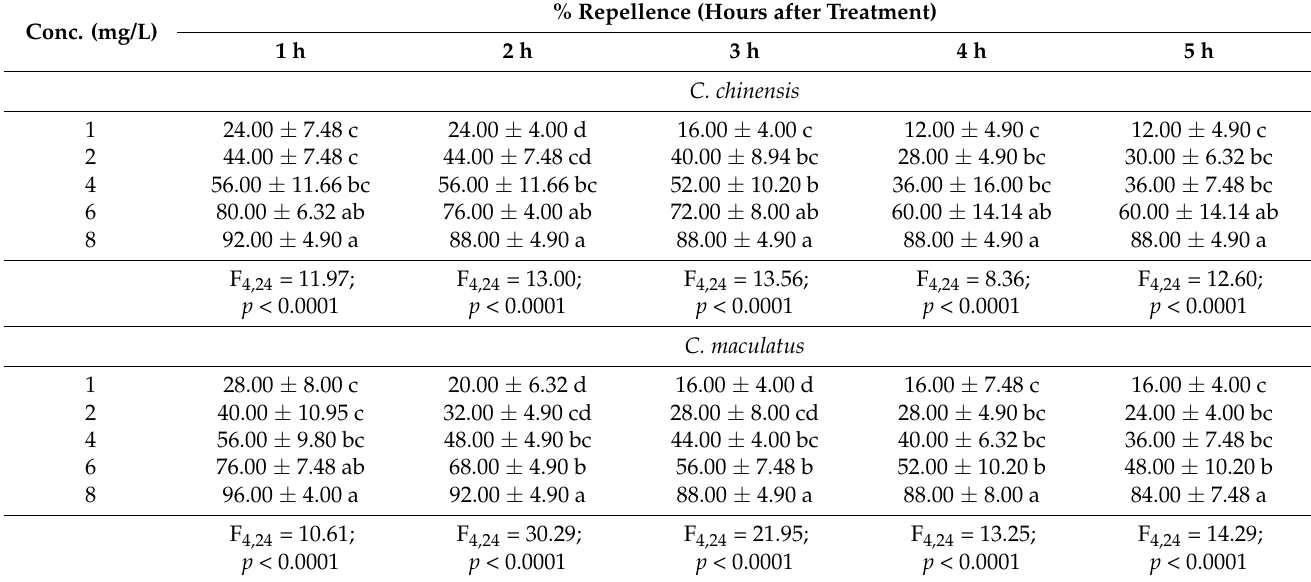
Table 5. Repellent activity of A. maritima oil against C. chinensis and C. maculatus